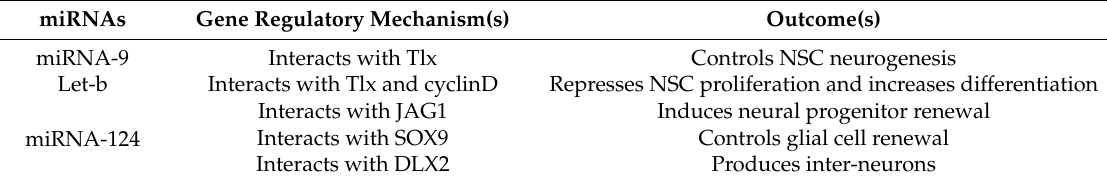
Table 4. Epigenetic regulations of gene expression by micro-RNAs. Different miRNAs are involved in gene expression, which are associated with differentiation, proliferation and neurogenesis of neuronal stem cells [13,70,71].